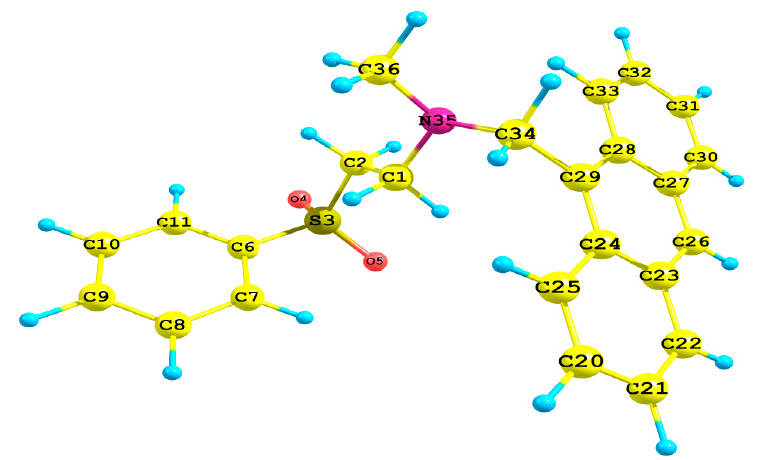
Figure 7. The optimized molecular structure of aza-Michael product 3 .